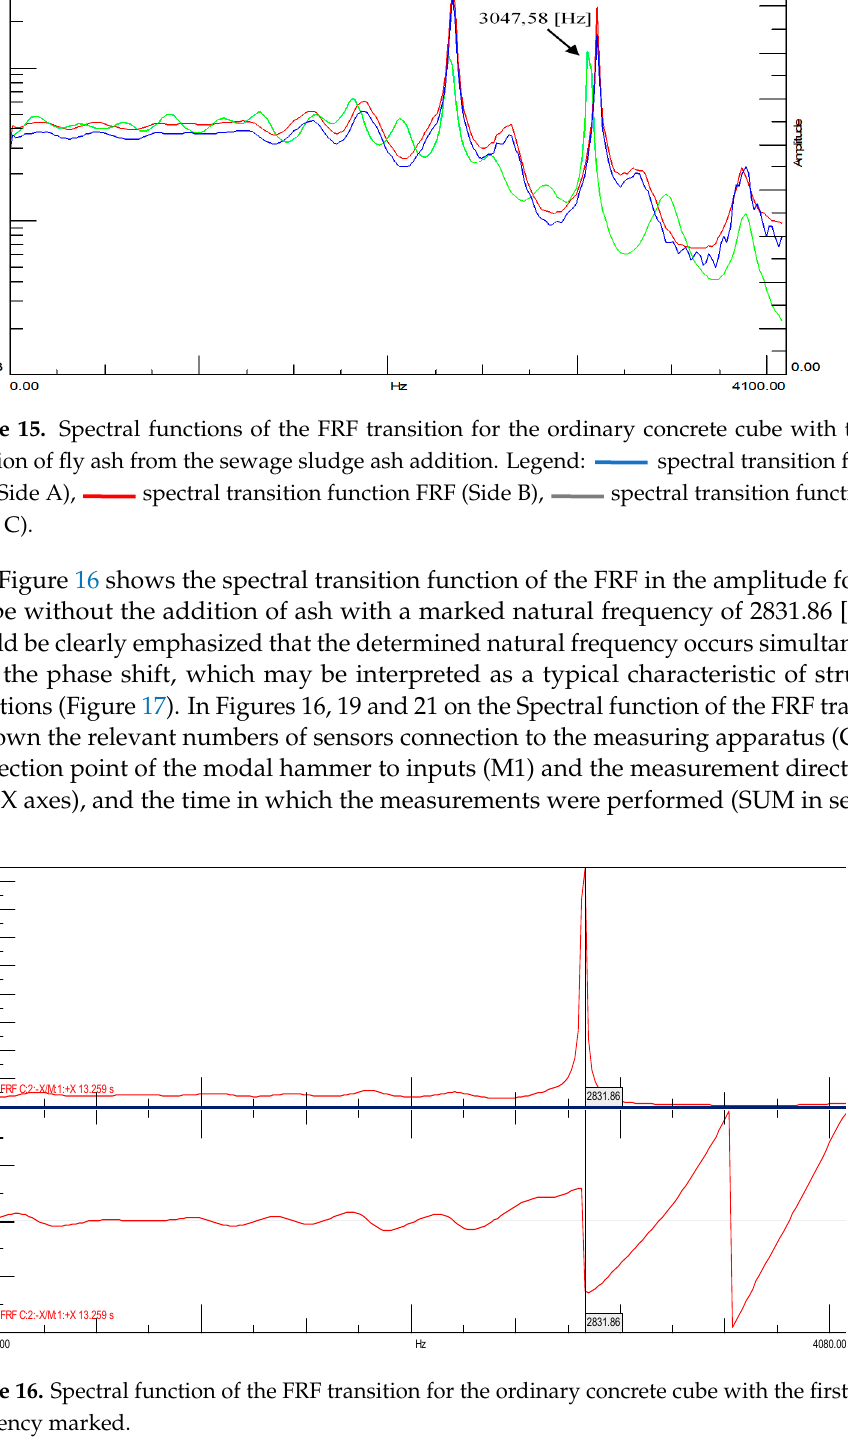
Figure 14. Spectral functions of the FRF transition for ordinary concrete cube. Legend: spec- tral transition function FRF (Side A), spectral transition function FRF (Side B), spectral transition function FRF (Page C).